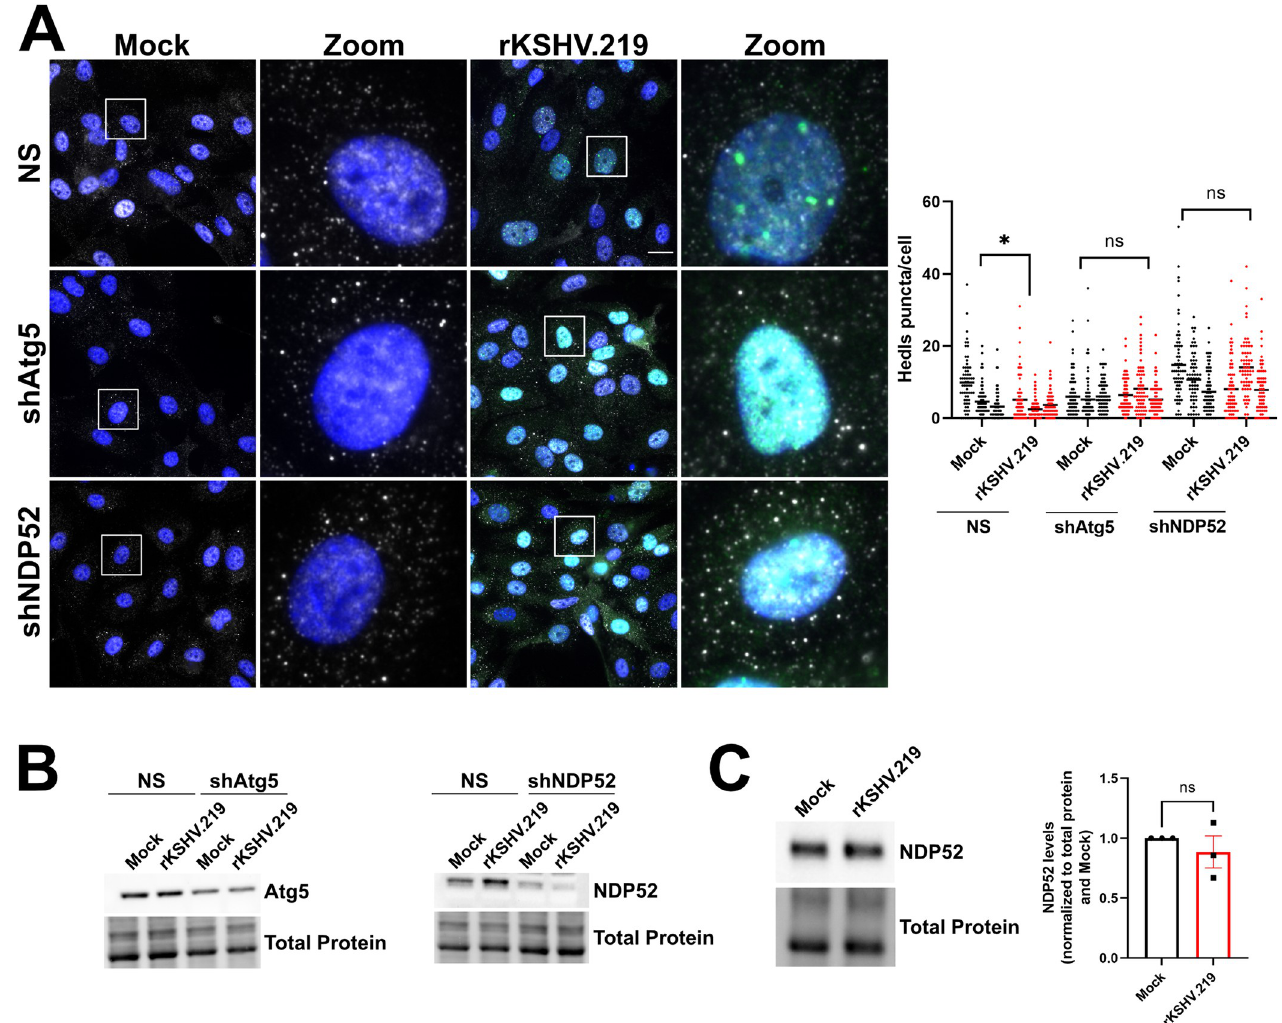
Fig 9. KSHV-mediated PB disassembly requires Atg5 and the selective autophagy receptor NDP52. A: HUVECs were transduced with recombinant lentivirus expressing shRNAs targeting Atg5, NDP52, or a non-targeting control (NS) and selected with puromycin (1 μ g/mL). Cells were infected with rKSHV.219 via spinoculation and infection was allowed to proceed for 96 h. Coverslips were fixed in 4% paraformaldehyde, permeabilized in 0.1% Triton X- 100 and immunostained for Hedls (PBs; white), LANA (KSHV latency, green), and DAPI (nuclei, blue). Scale bar = 20 μ m. Hedls puncta were quantified using CellProfiler and presented as number of Hedls puncta per cell, all cells counted are displayed. Results were plotted in GraphPad and a 2-way ANOVA was performed on the main column effects with a Tukey’s multiple comparison test, bar represents the mean; n = 3, � = P < 0.05. B: HUVECs were transduced with recombinant lentiviruses and infected with rKSHV.219 as in A. Cells were harvested in 2X Laemmli buffer. Protein lysates were resolved by SDS-PAGE and immunoblot was performed for Atg5 and NDP52. C: HUVECs were infected with rKSHV.219 via spinoculation and infection was allowed to proceed for 96 h. Cells were harvested in 2X Laemmli buffer. Samples were resolved by SDS-PAGE and immunoblot was performed for NDP52. Samples were quantified by normalizing NDP52 protein levels to the total protein in each lane using Image Lab (BioRad) and then to Mock. Results were plotted in GraphPad and an unpaired t-test was performed, ± SEM; n = 3, � = P <